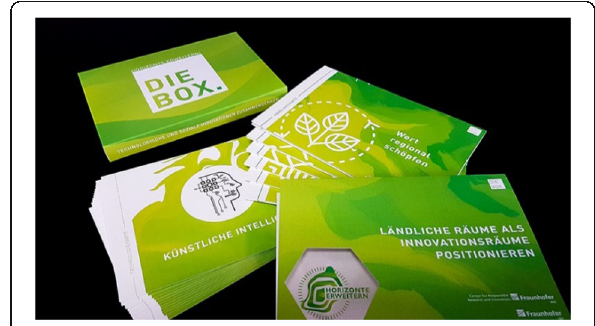
Fig. 6 Toolbox for shaping the future of rural areas